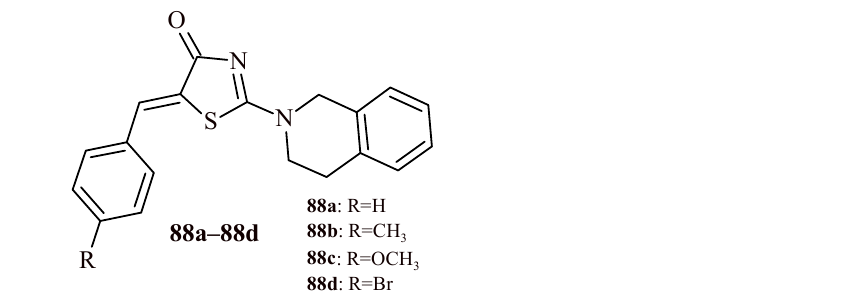
the blood glucose level. The administration of Compound 88d at dose of 30 mg/kg daily for 21 days significantly reduced the intestinal α -amylase activity by 21.3% in comparison with untreated diabetic rats, decreased the blood glucose level by 39% [89].